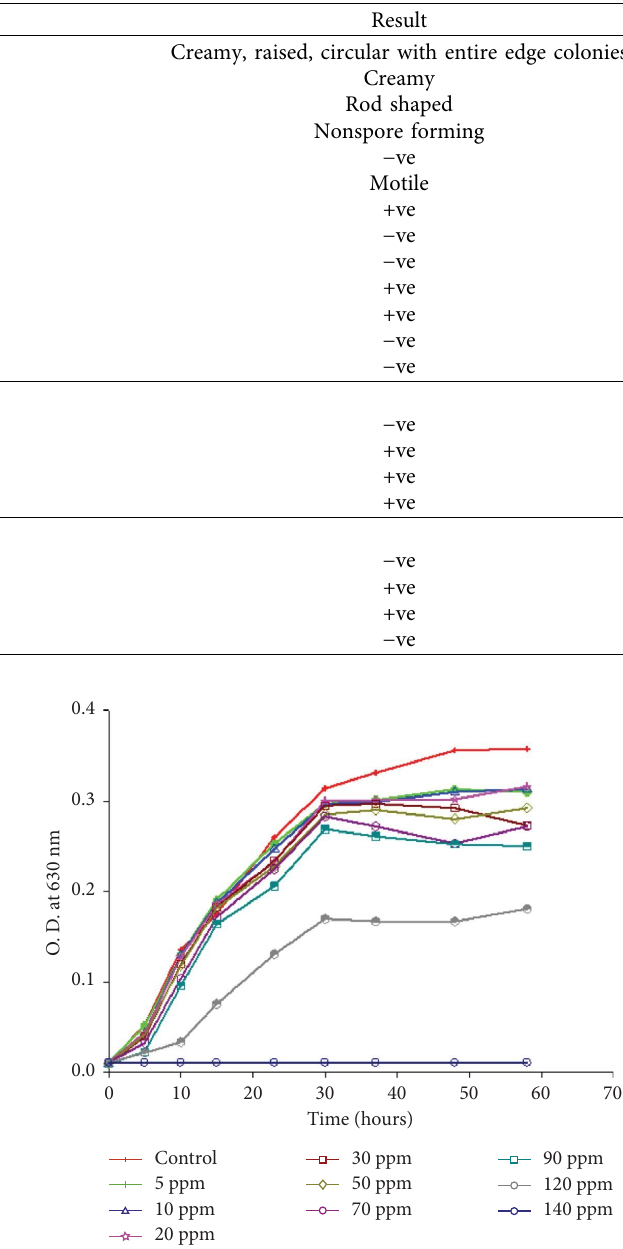
Figure 2: Growth pattern of D. tsuruhatensis SA-101 on diferent concentrations of Zn(II) metal (5–140 ppm) at 37 ° C for 60